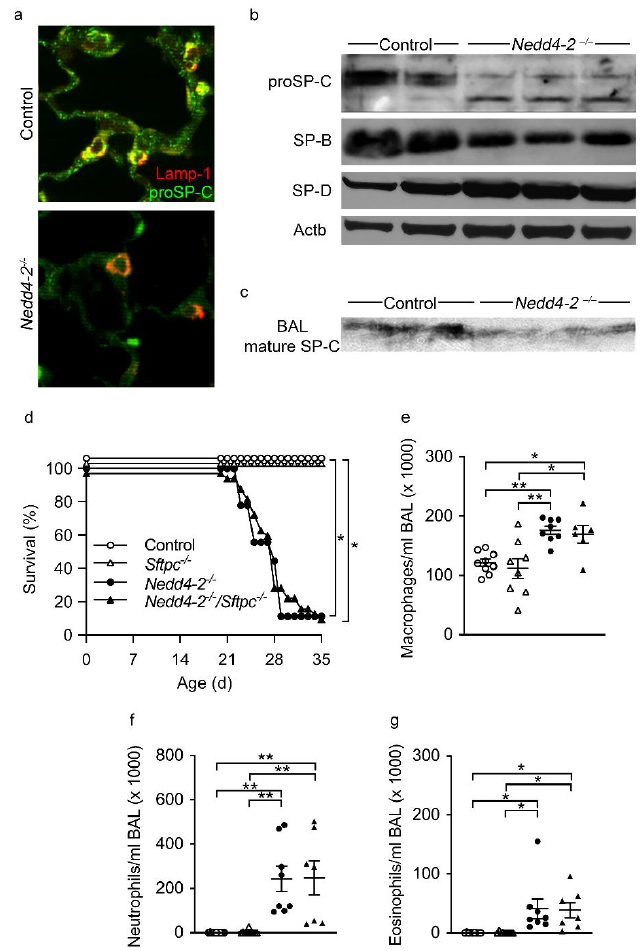
Figure 7. Evidence of proSP-C mistrafficking in lung epithelial cells of congenital Nedd4-2 −/− mice: ( a ) Representative confocal images of double label fluorescence immunohistochemistry for proSP-C (green) and Lamp-1 (red). ( b ) Western blots for proSP-C, SP-B and SP-D from lung homogenates of 3-week-old congenital Nedd4-2 −/− and control mice. ( c ) Western blots for mature SP-C in BAL of 3-week-old congenital Nedd4-2 −/− and control mice. ( d ) Survival curve of congenital Nedd4-2 −/− , congenital Nedd4-2 −/− /Sftpc −/− , littermate Sftpc −/− and control mice. n = 9–32 mice per group. * p < 0.05. ( e – g ) Number of macrophages ( e ), neutrophils ( f ) and eosinophils ( g ) in BAL of 3-week-old congenital Nedd4-2 −/− , congenital Nedd4-2 −/− /Sftpc −/− , littermate Sftpc −/− and control mice. n = 7–9 mice per group. * p < 0.05, ** p < 0.01. Data are shown as mean ± S.E.M.